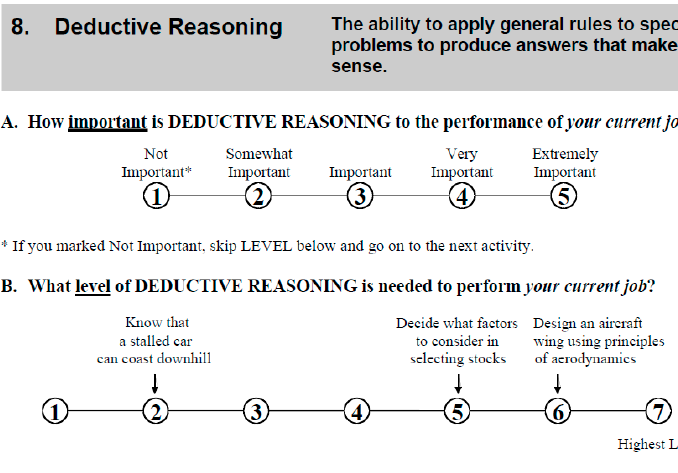
Figure 2 . Sample item from the O*NET Abilities Questionnaire. Figure 2. Sample item from the O*NET Abilities